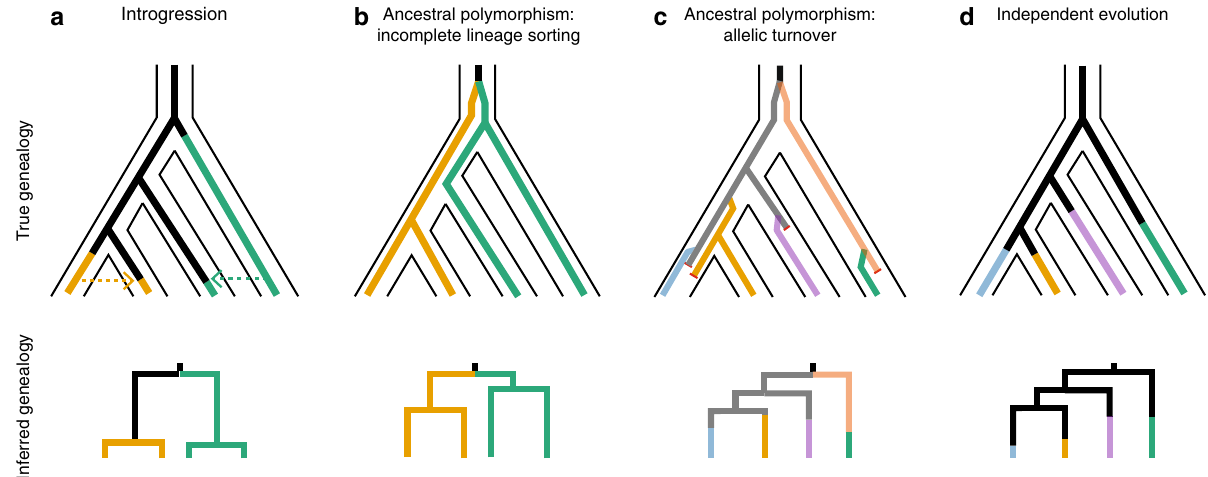
Fig. 1 True (top row) and inferred (bottom row) genealogies under four mimicry evolution hypotheses. Colors represent distinct mimicry alleles/ phenotypes. a Mimicry alleles are shared because of introgressive hybridization. b Mimicry evolves ancestrally, and descendant lineages inherit and maintain the ancestral alleles. c Mimicry evolves ancestrally, and alleles are gained and lost so that the extant alleles are distinct from the ancestral alleles. d Unique mimicry alleles arise by the independent evolution of mimicry. Under introgression and incomplete lineage sorting (ILS), the inferred genealogies will show alleles grouping by phenotype rather than species ( a , b ), but the branch lengths will be relatively shorter for introgression than for ILS. Under allelic turnover and independent evolution, the inferred genealogies will result in alleles grouping by species ( c , d ), but the branch lengths are expected to be longer for allelic turnover because of underlying balancing selection. A history of allelic turnover will also leave behind population genetic signatures of balancing selection, such as elevated Tajima ’ s D in the region of interest. Under allelic turnover, the amount of shared ancestral variation should track phylogenetic relatedness, because recombination and gene conversion will erase the evidence of ancestral variants as a lineage ages. Because shared ancestral variation is more likely to be retained at younger timescales, allelic genealogies may show alleles of one species nested within another species for younger lineages. In contrast, independent evolution need not involve balancing selection, and if variants are shared among lineages, these should not be correlated with the lineages ’ phylogenetic